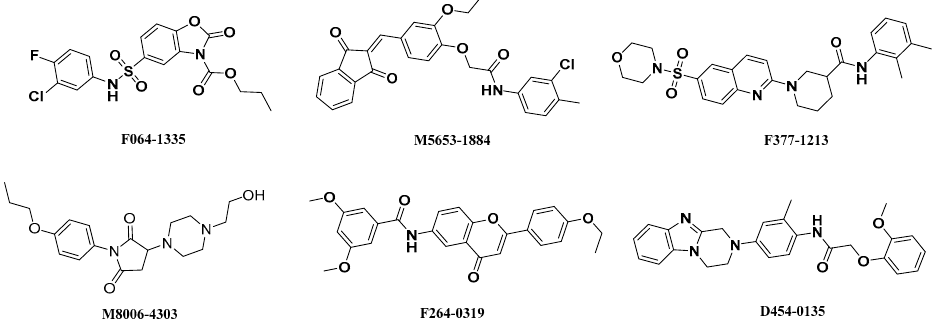
Figure 5. Structures of retrieved hits targeting α 1 β 1 γ 1 AMPK isoform from ChemDiv database.